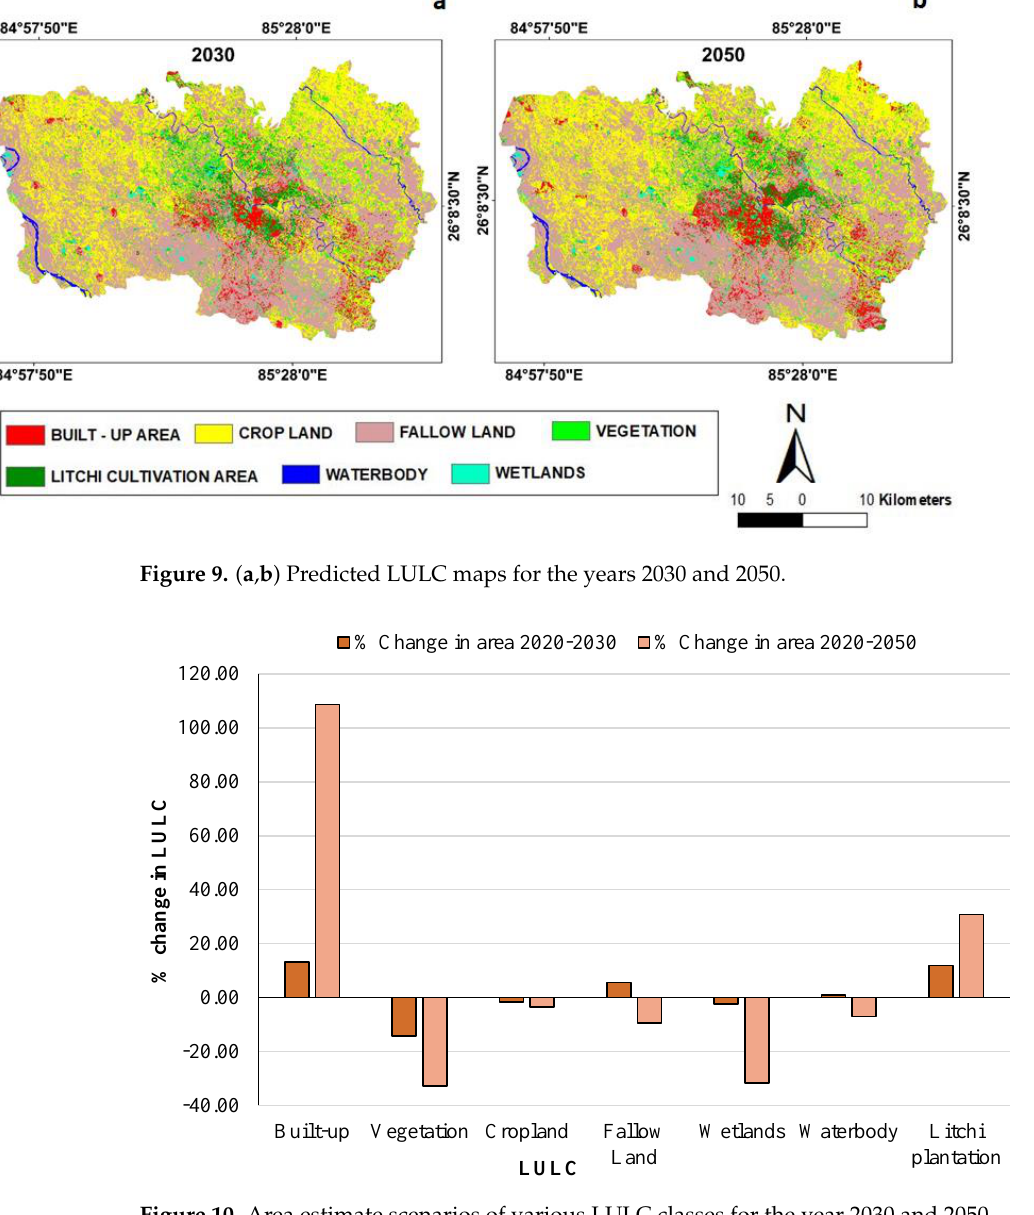
Figure 10. Area estimate scenarios of various LULC classes for the year 2030 and 2050.